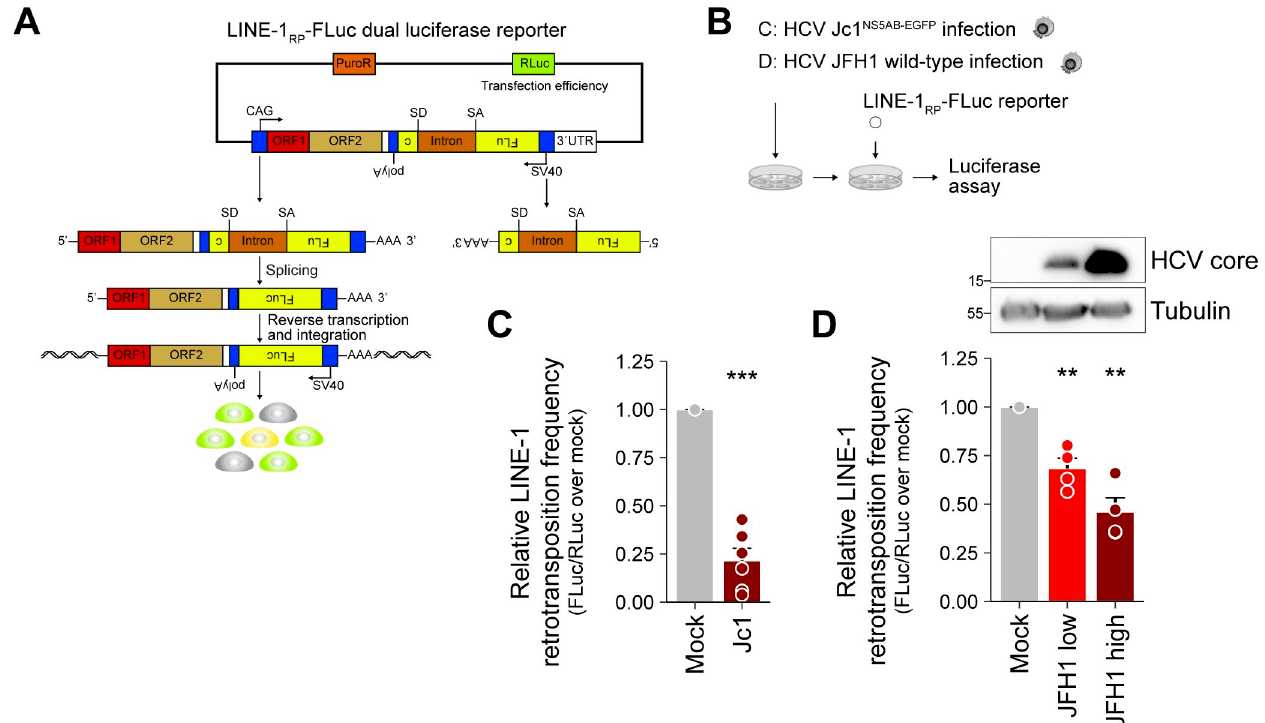
Fig 3. HCV infection decreases L1 retrotransposition frequency. (A) Scheme of the dual-luciferase L1 retrotransposition reporter assay expressing Renilla luciferase (RLuc) for transfection normalization and firefly luciferase (FLuc) as reporter for L1 retrotransposition (L1 RP -FLuc). The FLuc gene is in antisense orientation and interrupted by an intron in sense orientation flanked by splice donor (SD) and acceptor (SA) sites ensuring that FLuc is expressed only after splicing of its pre-mRNA, reverse transcription, and integration of an intact Fluc cDNA copy. Thus, FLuc activity is directly proportional to the number of L1 RP -FLuc de novo retrotransposition events. (B) Scheme of the experiments; the indicated cells were transfected with the L1 RP -FLuc reporter and luciferase assays were performed. (C) Mock or Jc1 NS5AB-EGFP -infected Huh7.5 cells (MOI 0.2) were transfected with L1 RP -FLuc at 7 dpi. Depicted is the relative L1 retrotransposition frequency 5 days after duplicate transfections from 3 independent experiments (mean ± SEM, n = 6, ��� p < 0.001, Welch’s t -test). (D) JFH1-infected Huh7 cells were cultured for ~6 months. Mock and JFH1-infected cells with low and high infection rates were transfected with L1 RP -FLuc. Shown is the relative L1 retrotransposition frequency 6 dpt of duplicate transfections from 2 independent experiments (mean ± SEM, n = 4, �� p < 0.01, Welch’s t -test). Immunoblot analysis of HCV core expression confirmed differences in infection rates.